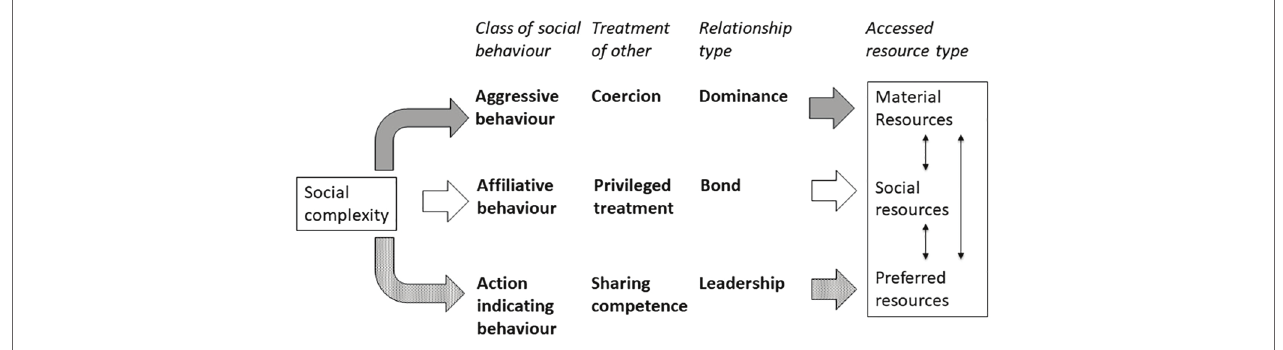
FIGURE 1 | Proposed relations between three classes of social behaviour, the effect of this social behaviour on the interaction partner, the ensuing relationship when the pattern is consistent, and the type of resources that may be accessed. Social complexity results from expressing different classes of social